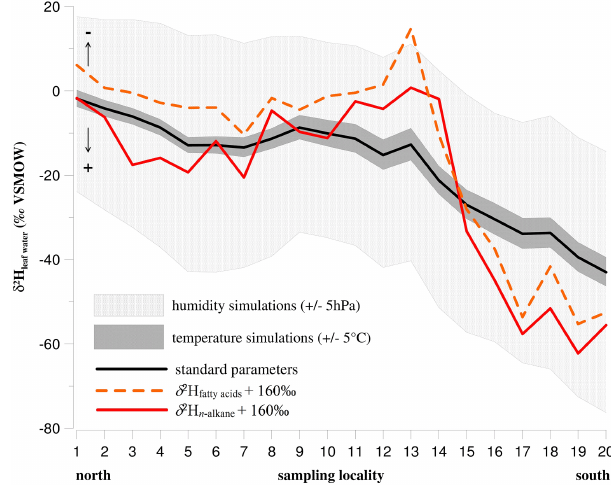
Figure 4. Results of δ 2 H leaf water model simulations and compar- ison with biomarker-based reconstructed (assuming a biosynthetic fractionation factor of − 160‰) isotopic composition of leaf water based on n -alkanes and fatty acids, respectively. Sensitivity tests for δ 2 H leaf water are shown for changes in RH and air temperature for all 20 sites along the